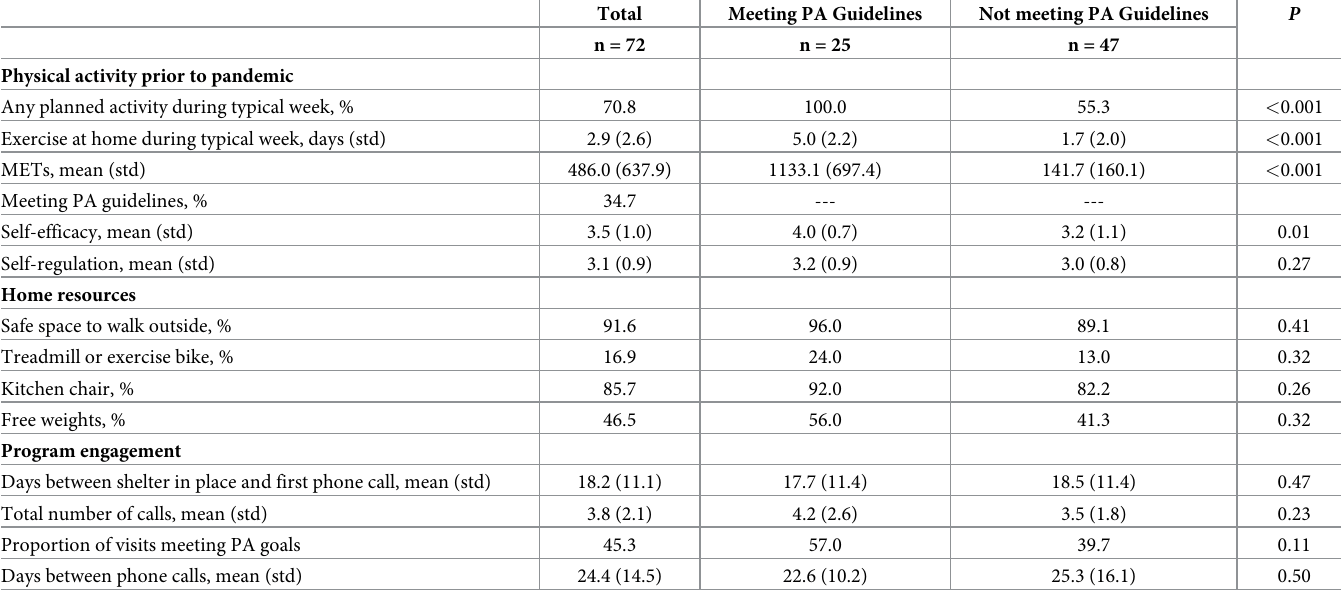
Table 2. Characteristics of patients with � 1 Wellness Center phone call, by physical activity status at baseline, n = 72. Total Meeting PA